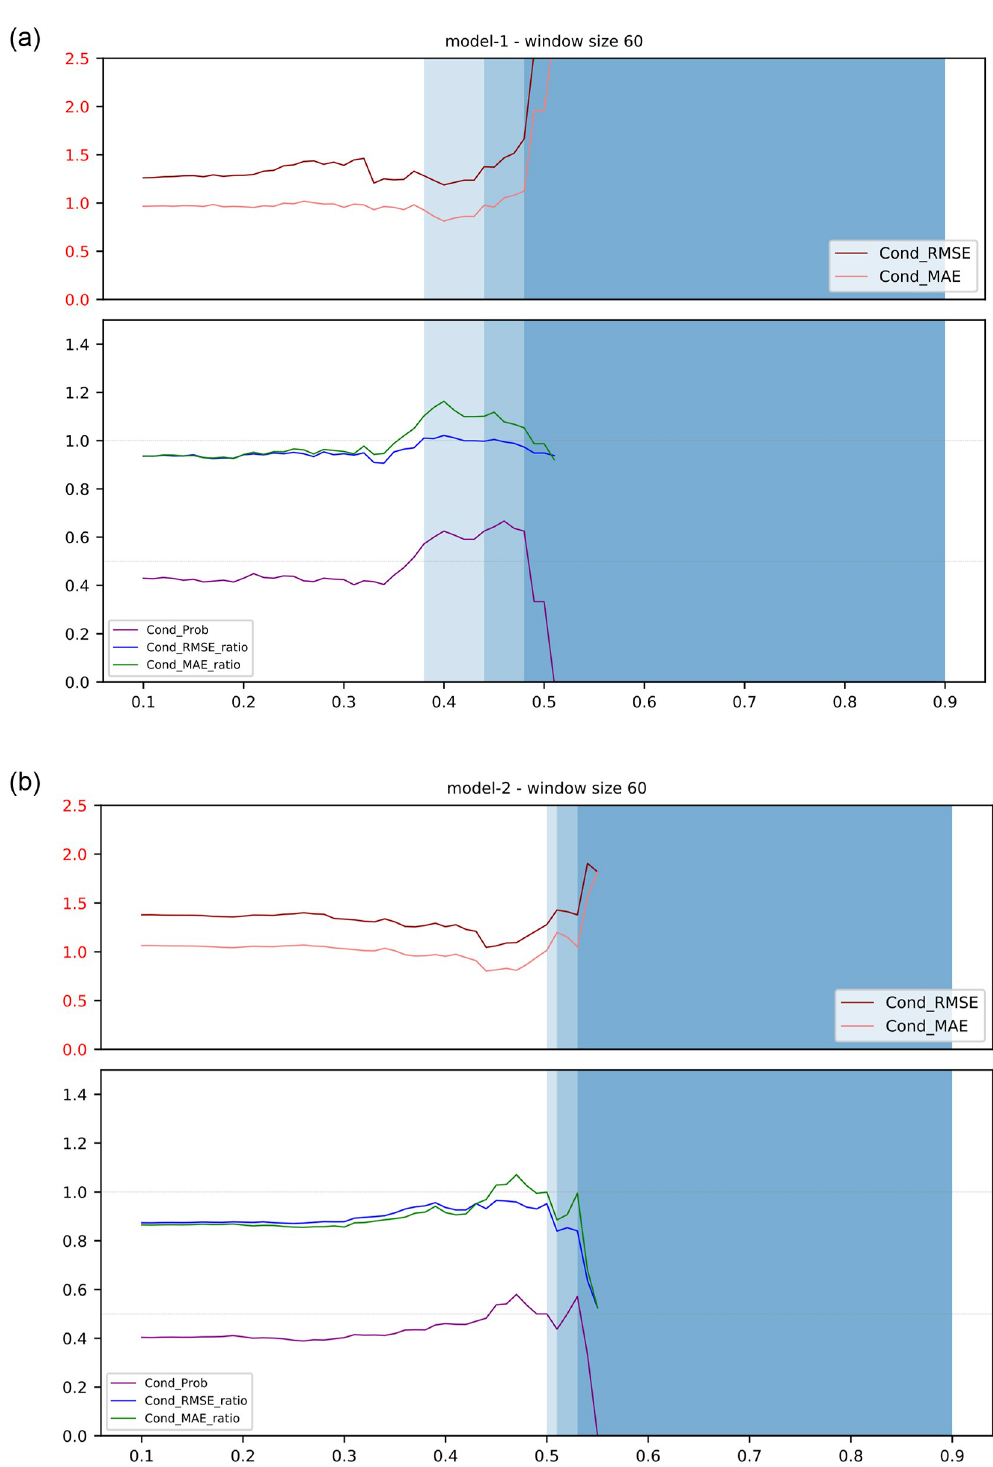
Fig 12. The graphs represent the two best models generated from the public data and the private data, respectively. The y-axis represents the value of the evaluation metrics whilst the x-axis represents the threshold . The top graph in each diagram shows the conditional RMSE and the conditional MAE, and the bottom graph shows the RMSE ratio, the MAE ratio, and the conditional probability. The shaded area indicates the number of days that the topic model was chosen. The darkest blue, mid blue, the lightest blue and white areas represent 0–10, 10–20, 20–30 and above 30 observations, respectively. (a) Best model for the public data. (b) Best model for the private data.